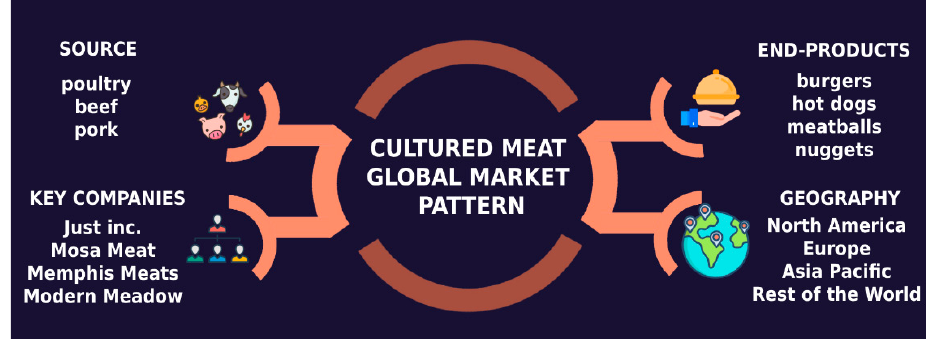
Figure 4. Cultured meat global market pattern (Source: https://www.verifiedmarketresearch.com [72]).